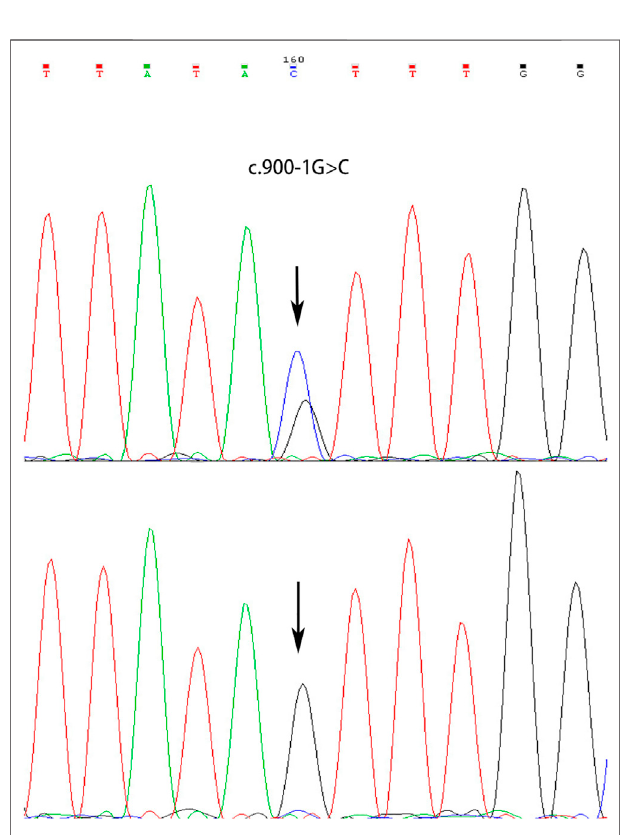
FIGURE 3 | Heterozygous splicing mutation in ATP2C1 identi fi ed in the proband and his mother (upper) and sequencing result of his father (normal, lower)